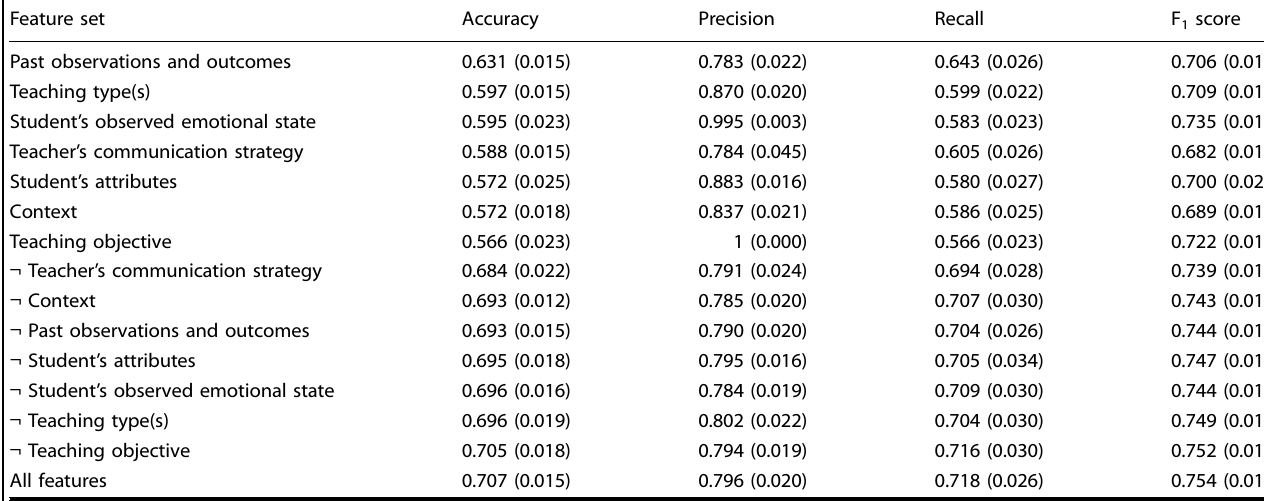
Table 4. Ablation analysis for the best performing model GP- α , τ = 1. Feature